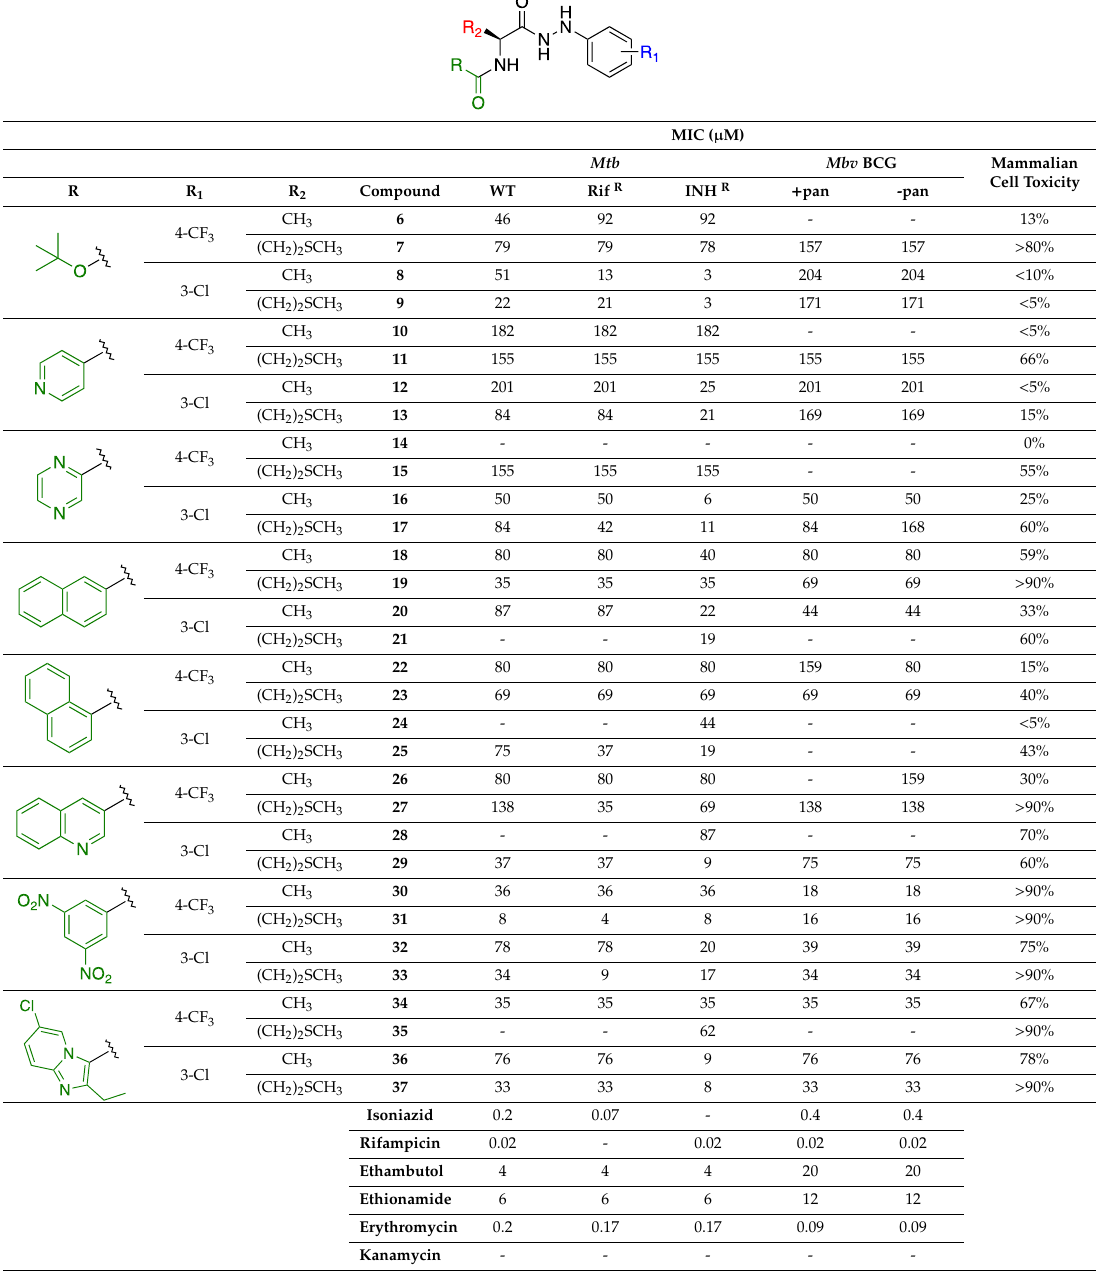
Table 1. Results of synthesis of substituted amino acid hydrazides and the antibacterial activity and cytotoxicity.